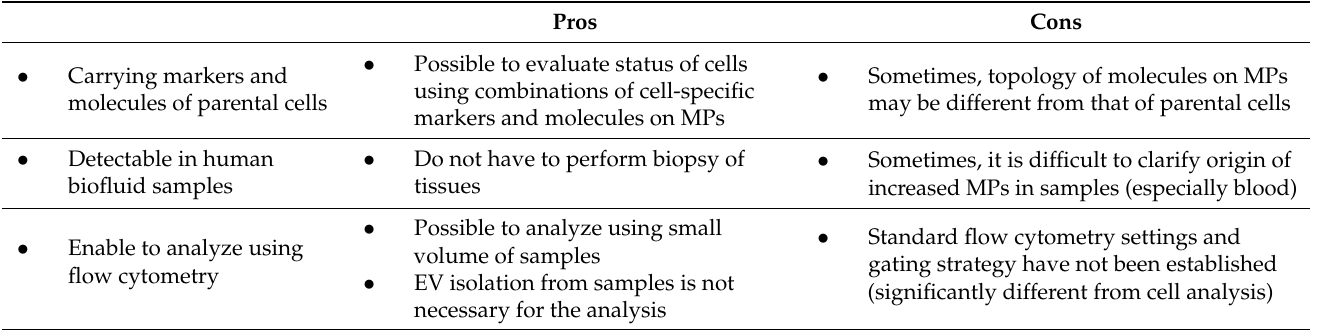
Table 3. Summary of pros and cons of MPs in human biofluids as biomarkers. Pros